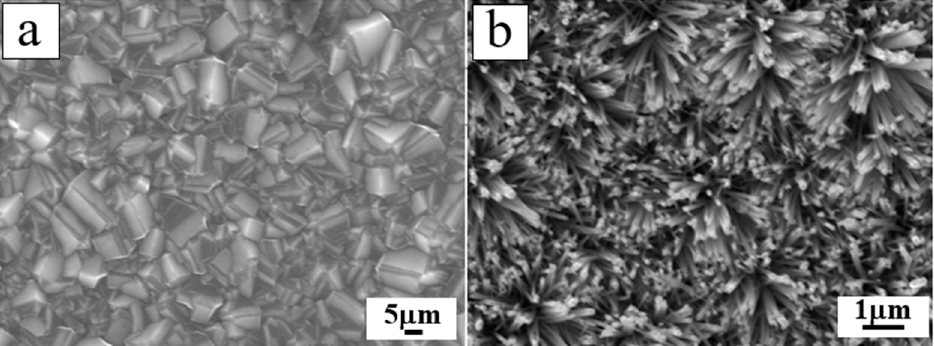
Figure 13. SEM morphology of ( a ) the plan view of the BDD film, ( b ) ZnO NWs deposited on the BDD film [30].